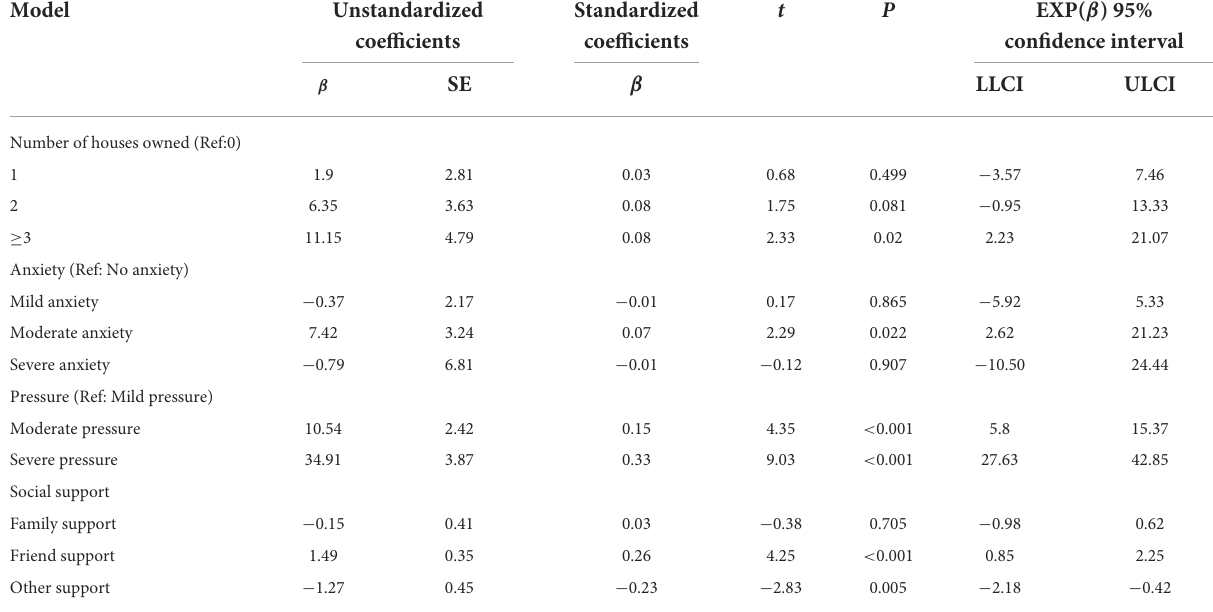
TABLE 5 Regression model of accept willingness to organ donation among people with media occlusion.